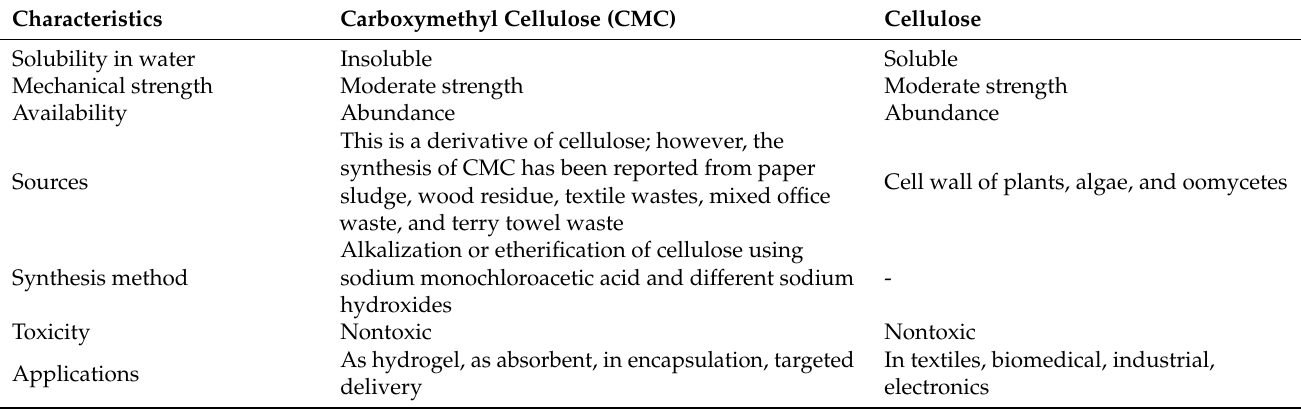
Table 2. Differences between cellulose and carboxymethyl